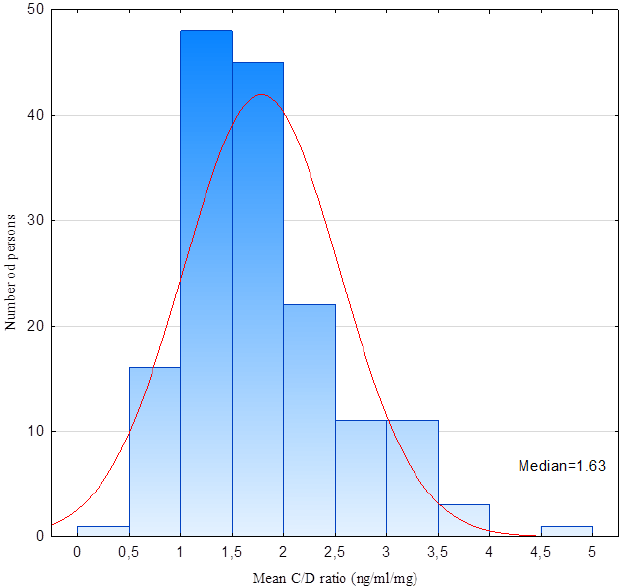
Figure 1. Histogram of the distribution of the C/D ratio (ng/mL/mg). The patients showed non- normal distribution. Median value — 1.63.